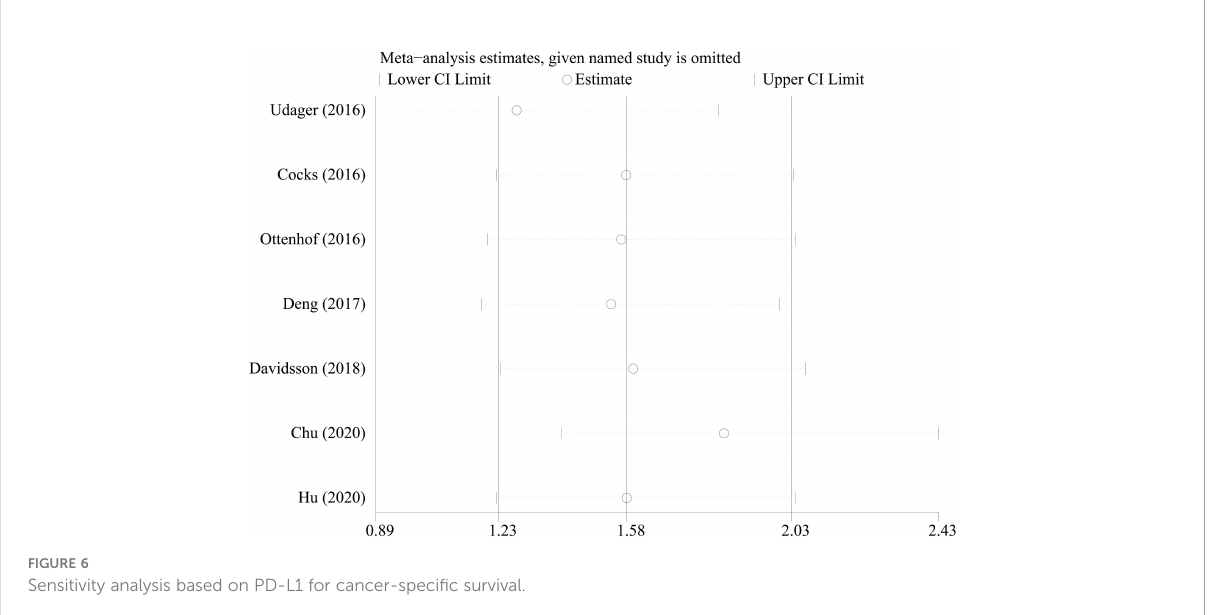
FIGURE 6 Sensitivity analysis based on PD-L1 for cancer-speci fi c survival.